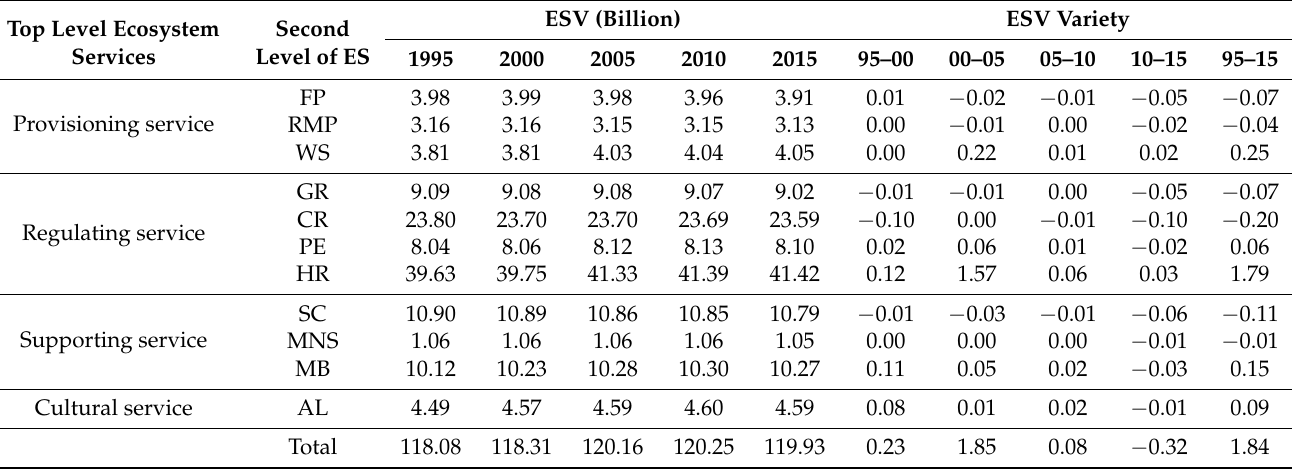
Table 5. ESVs for different functions in Hubei Province from 1995 to 2015